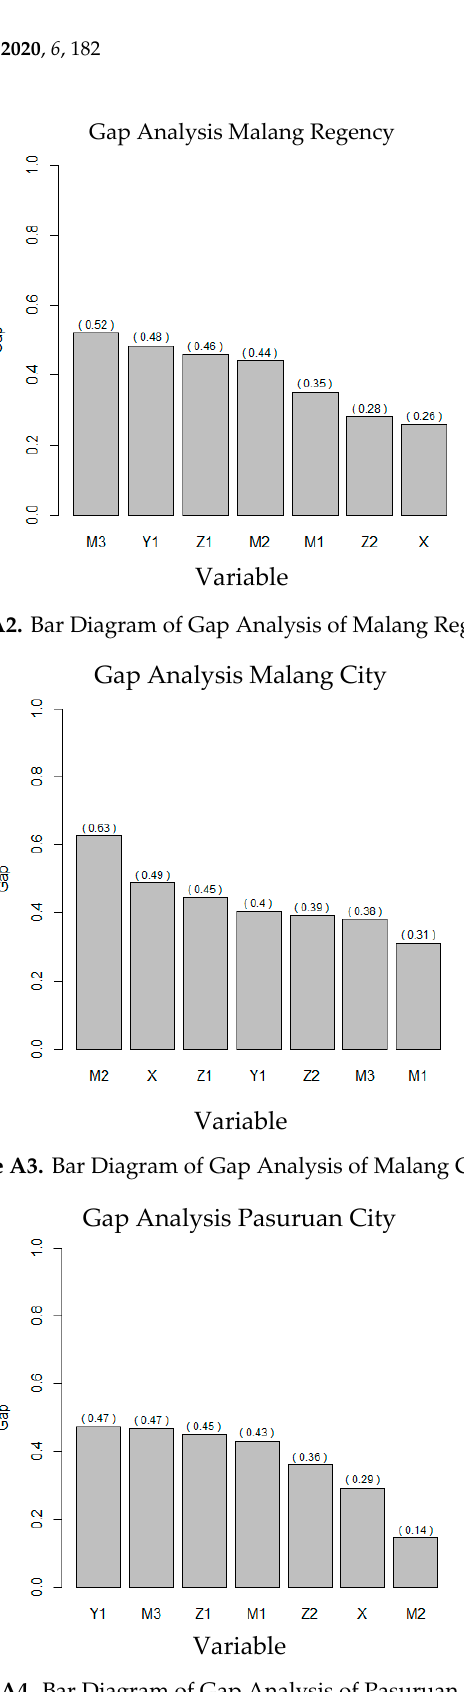
Variable Figure A5. Bar Diagram of Gap Analysis of Pasuruan Regency. Gap Analysis Sidoarjo Regency